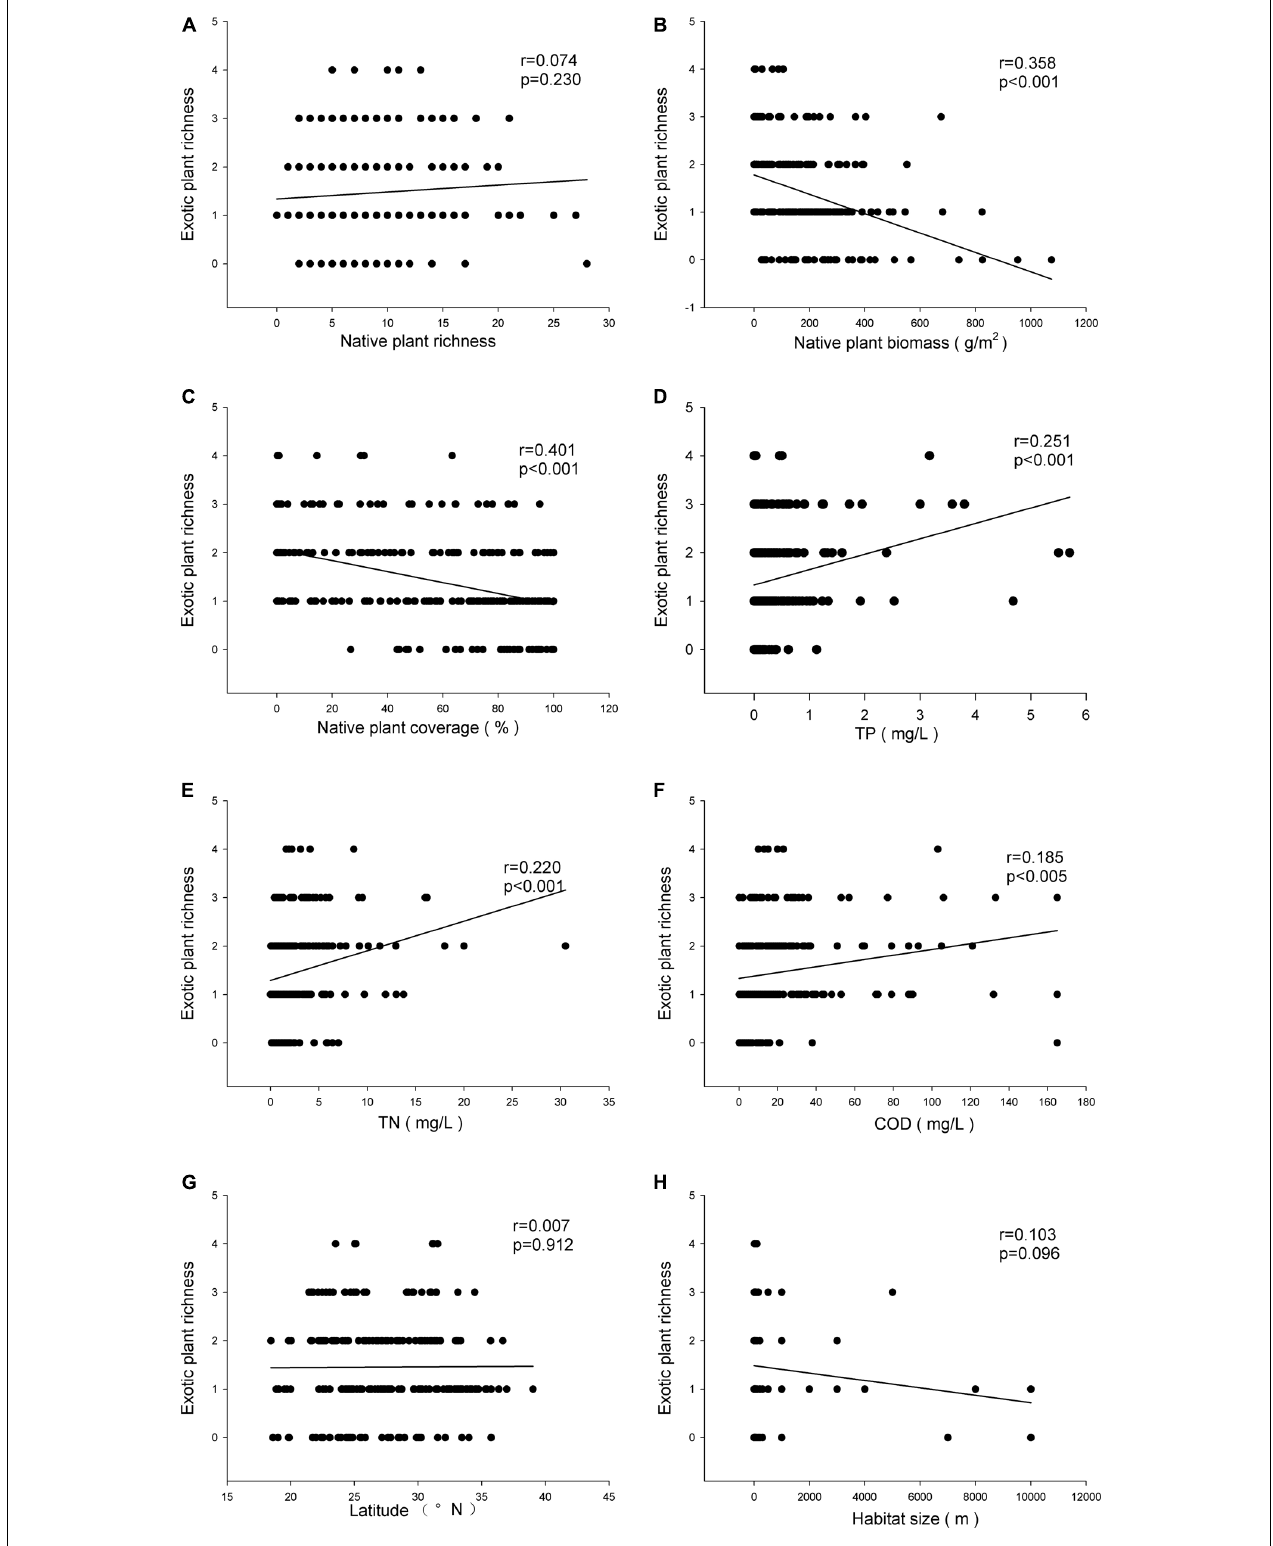
FIGURE 2 | Relationships of invasive plant richness with native plant richness (A) , mean biomass of native plants (B) , relative coverage of native plants (C) , TP (D) , TN (E) , COD (F) , latitude (G) , and habitat size (H) .